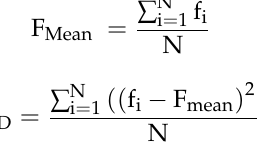
Table 3. Analysis of statistical results on the fixed benchmark functions.